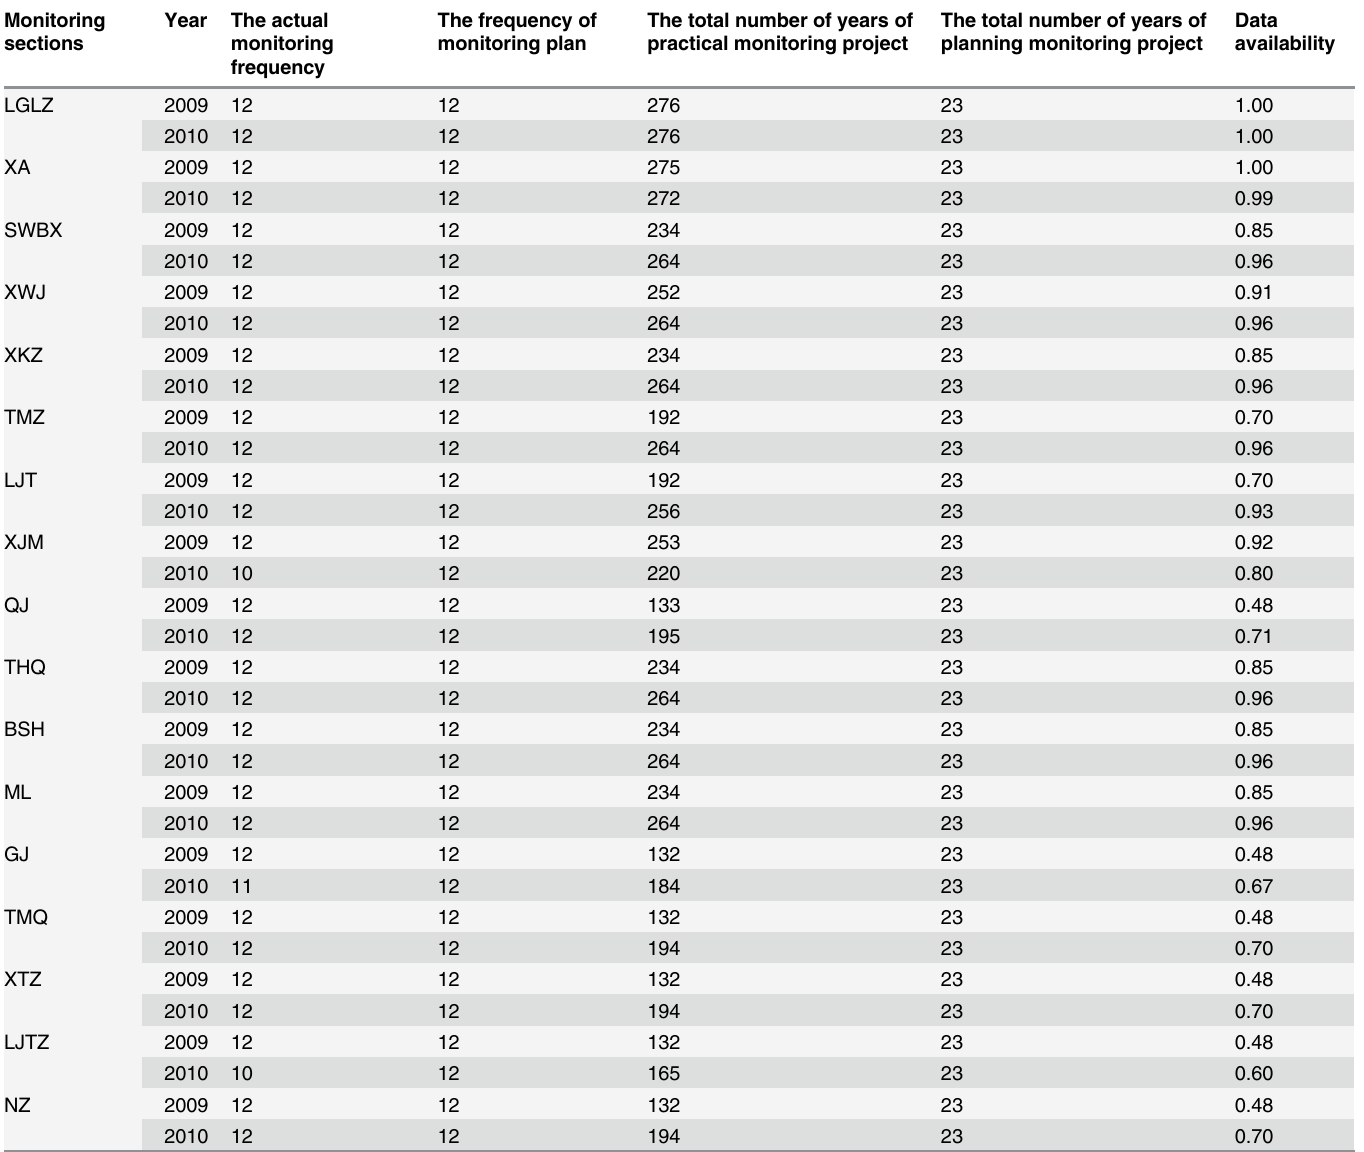
Table 2. Data availability of monitoring sections in Taizi